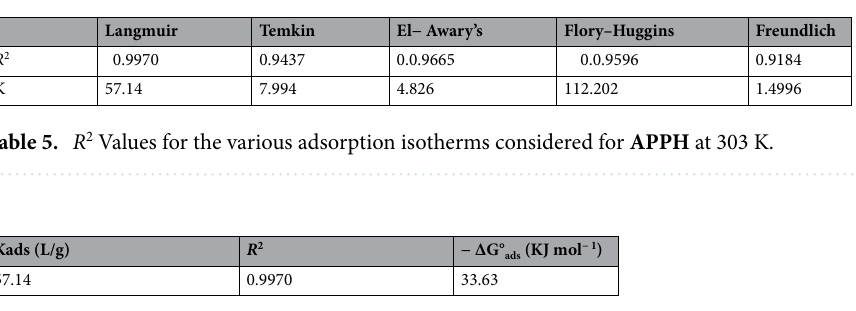
Table 6. Thermodynamic parameters of (APPH) adsorption on LCS in 0.5 M H 2 SO 4